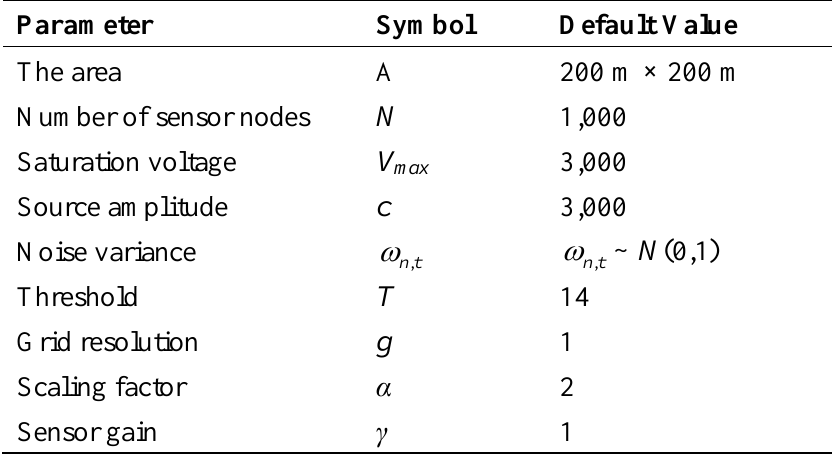
Table 1. Default Parameter